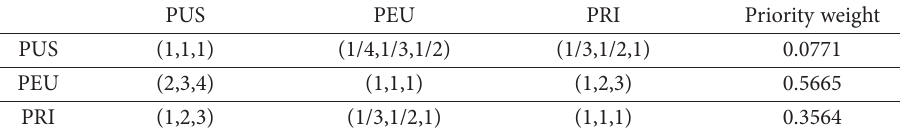
Table 6. Fuzzy evaluation of the main factors